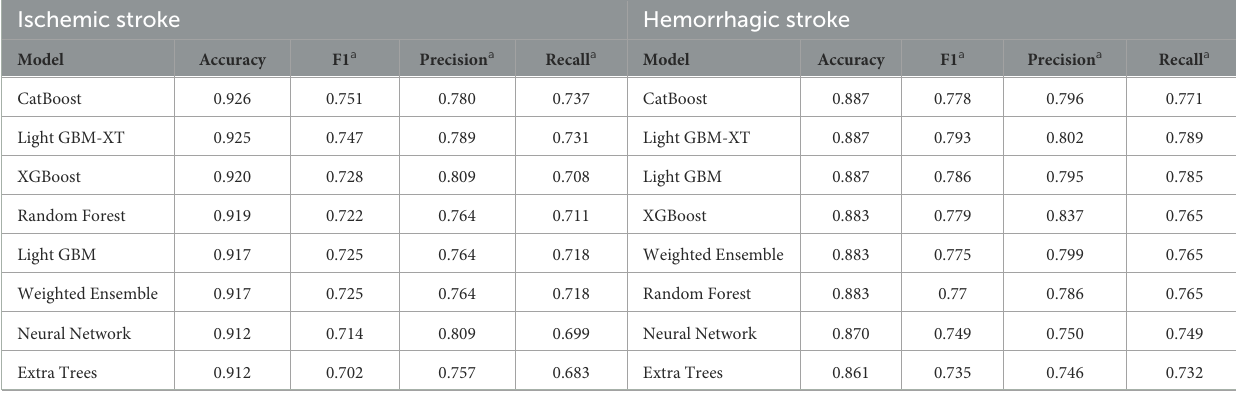
TABLE 2 Performance scores of the prediction models. Ischemic